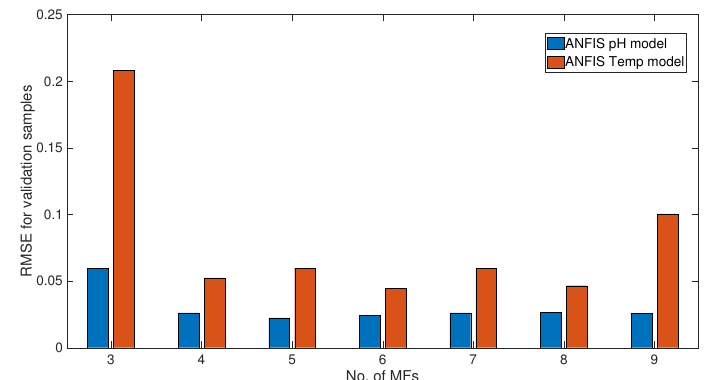
Figure 2. SISO FIS models: ( a ) Temp- Enzyme activity FIS structure. ( b ) pH- Enzyme activity FIS structure.